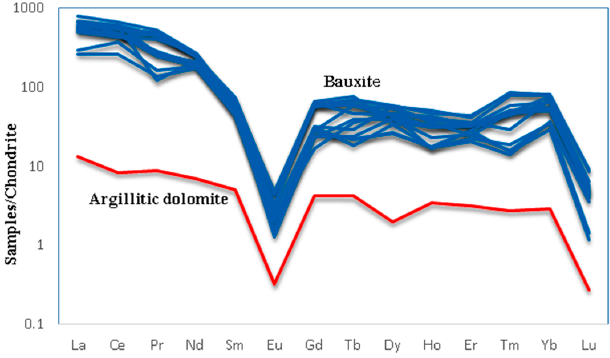
Figure 9. Chondrite-normalized rare earth element (REE) patterns of the bauxite samples as well as argillitic dolomite from the Khaneh–Kat Formation.